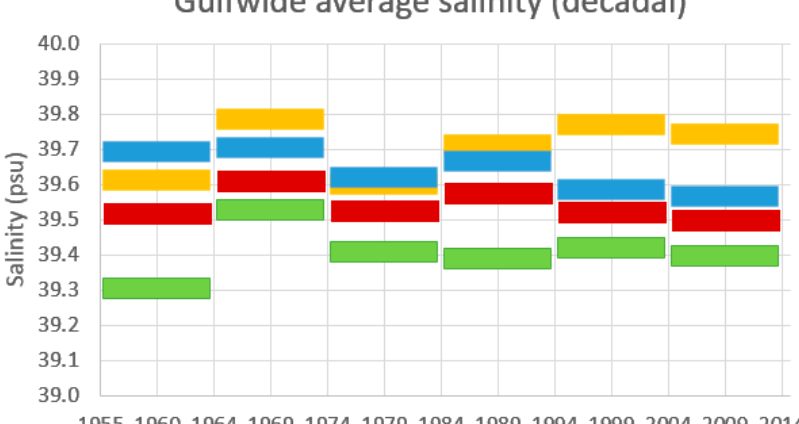
Figure 4. Decadal variability of Gulf-wide average salinity, 1955–2012. Data taken from [24].